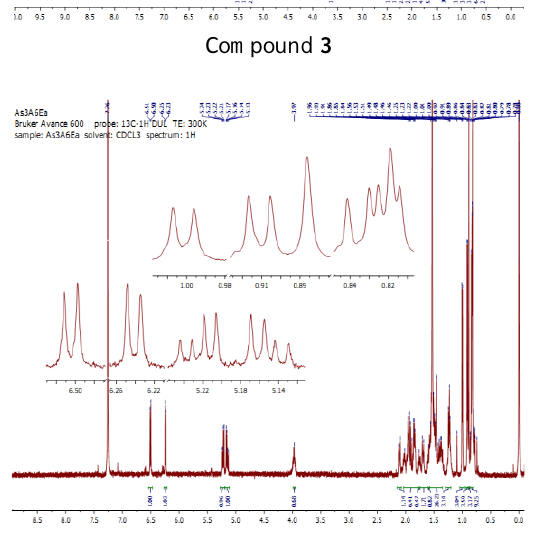
Fig.3. l H NMR spectral data of ergosterol ( 3 )